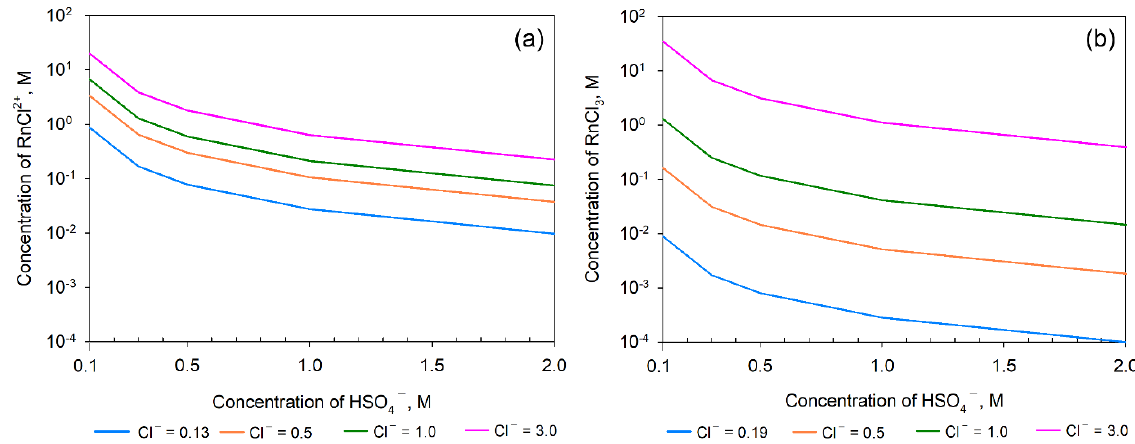
Figure 6. Effect of Cl − on the precipitation of ( a ) RnCl 2+ ; and ( b ) RnCl 3 .